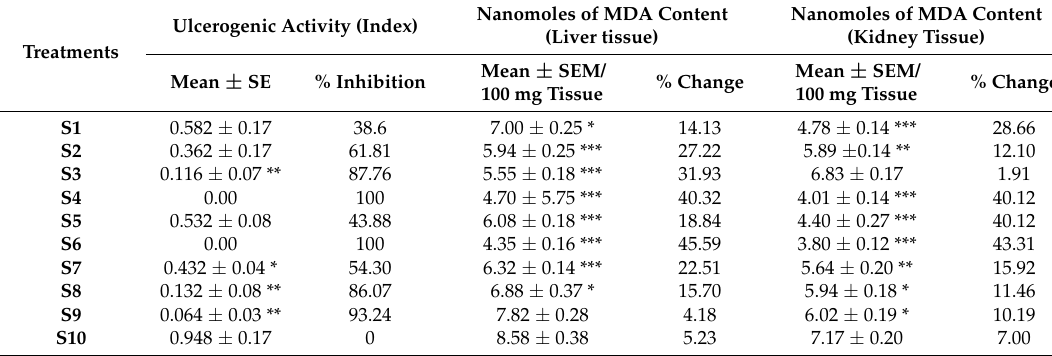
Table 3. Ulcerogenic and lipid peroxidation activity of compounds ( S1 – S18 ) in liver and kidney